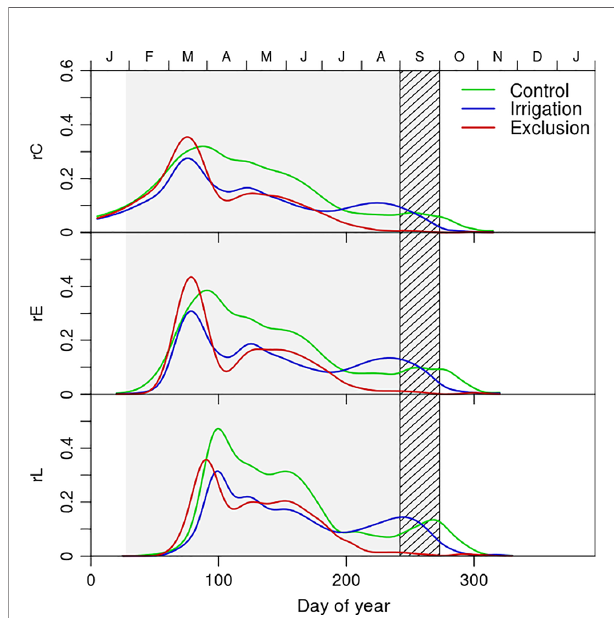
FIGURE 3 | Rate of cambial cell division (rC) and rate of cell entrance in enlargement (rE), and cell wall deposition phase (rL) of control (green line), exclusion (red line), and irrigation (blue line) trees. Gray shaded area corresponds to the rain exclusion period and the diagonal line area to the irrigation